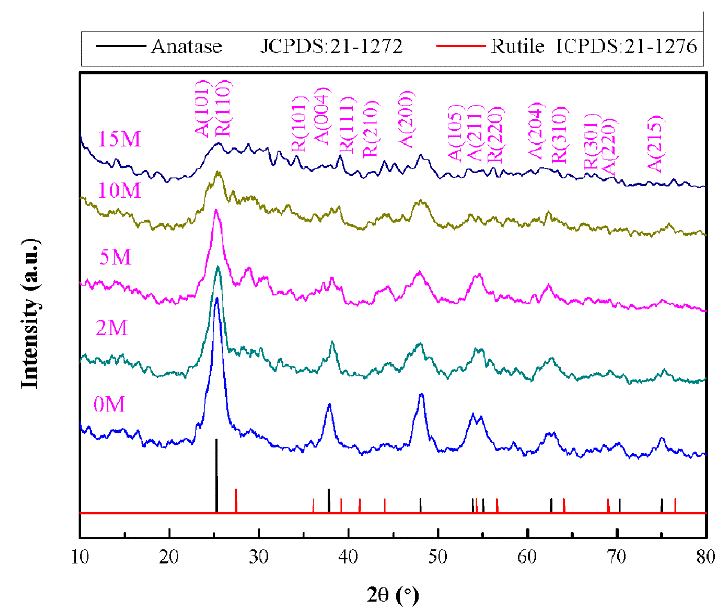
Figure 1. XRD patterns of as-prepared samples.